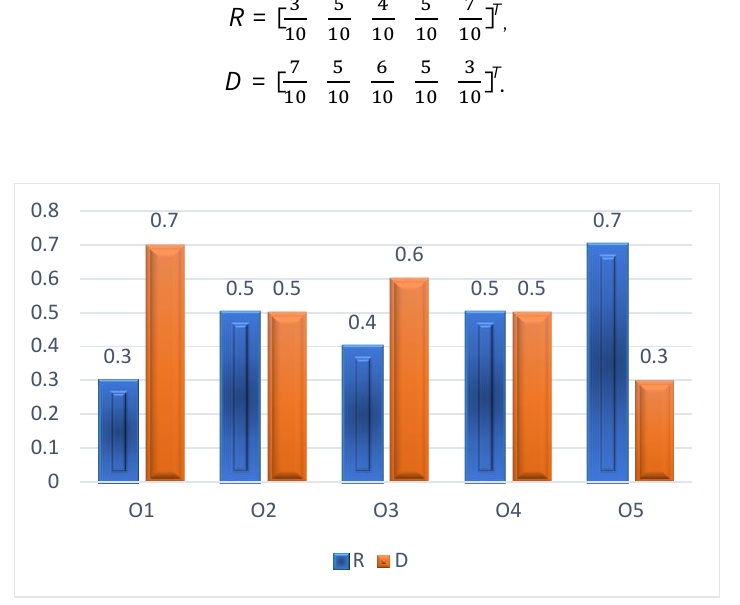
Figure 2. Robustness and debility of the